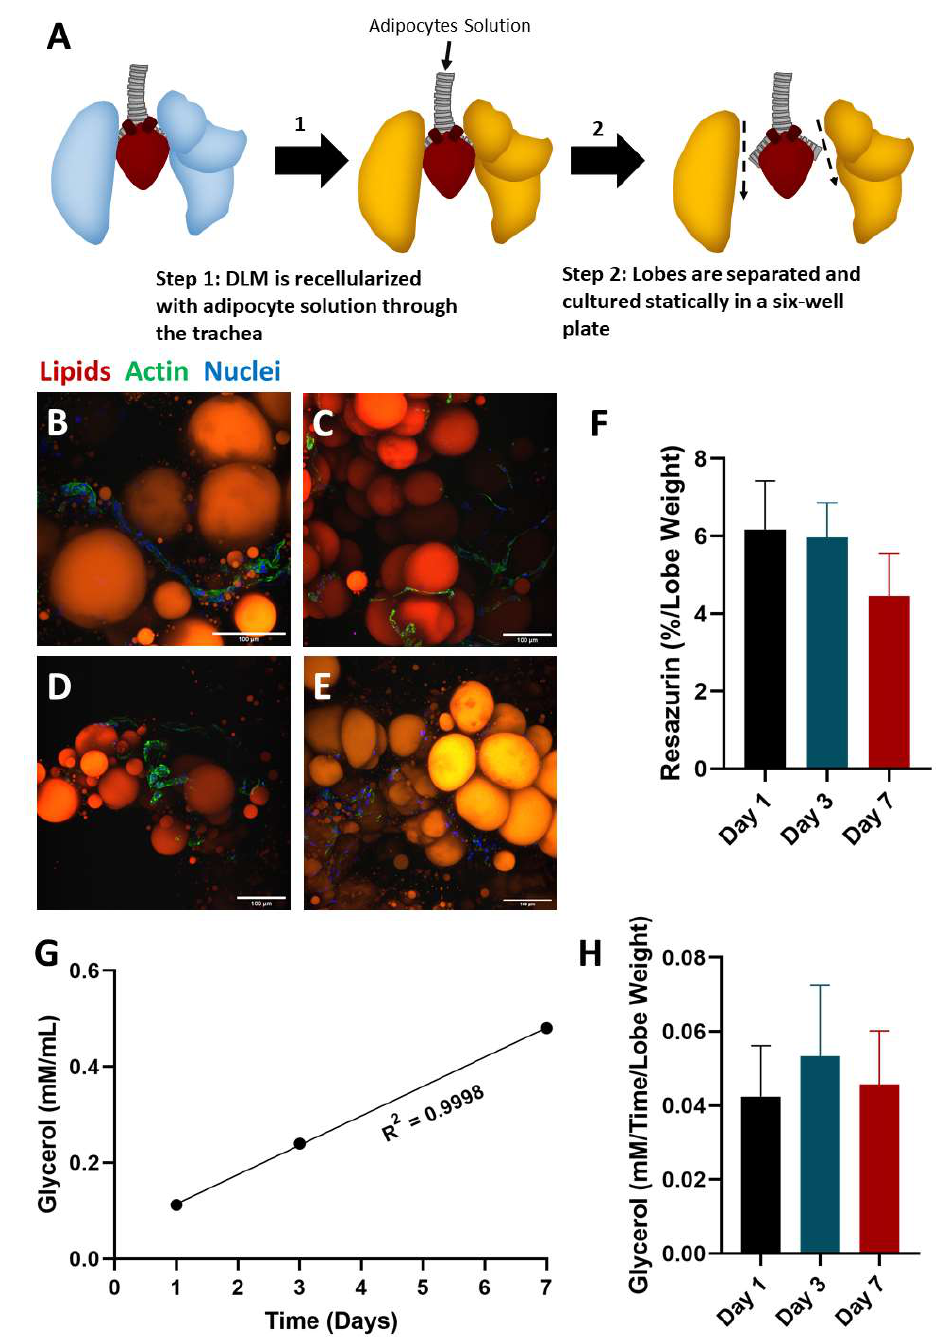
Figure 2. DLM cultured in static conditions supports adipocyte morphology and function. ( A ) Schematic showing how the DLM was seeded, separated, and cultured statically. Lobes were fixed and stained on days ( B ) 0, ( C ) 1, ( D ) 3, and ( E ) 7 (red—adipocytes, green—actin, blue—nuclei). Throughout culture, adipocytes maintained similar sizes and shapes (unilocular intracellular lipid droplets) in the presence of SVF cells (actin positive cells). Extracellular lipid droplets (lipid droplets without nuclei) were present at every timepoint. Scale bars = 100 µm. ( F ) Metabolic activity at each timepoint normalized to lobe weight. No statically significant relationships were detected ( p > 0.05). n = 3. ( G ) Glycerol levels for the lobe cultured for 7 days show consistent levels of glycerol production throughout the 7 days indicating the adipocytes remained functional after seeding and throughout culture (linear regression with a goodness of fit = 0.9998). n = 1 for each timepoint. ( H ) Glycerol levels at each timepoint normalized to culture time (in days) and lobe weight. No statistically significant relationships were detected ( p > 0.05). n = 4 for day 1, n = 3 for day 3, and n = 2 for day 7.